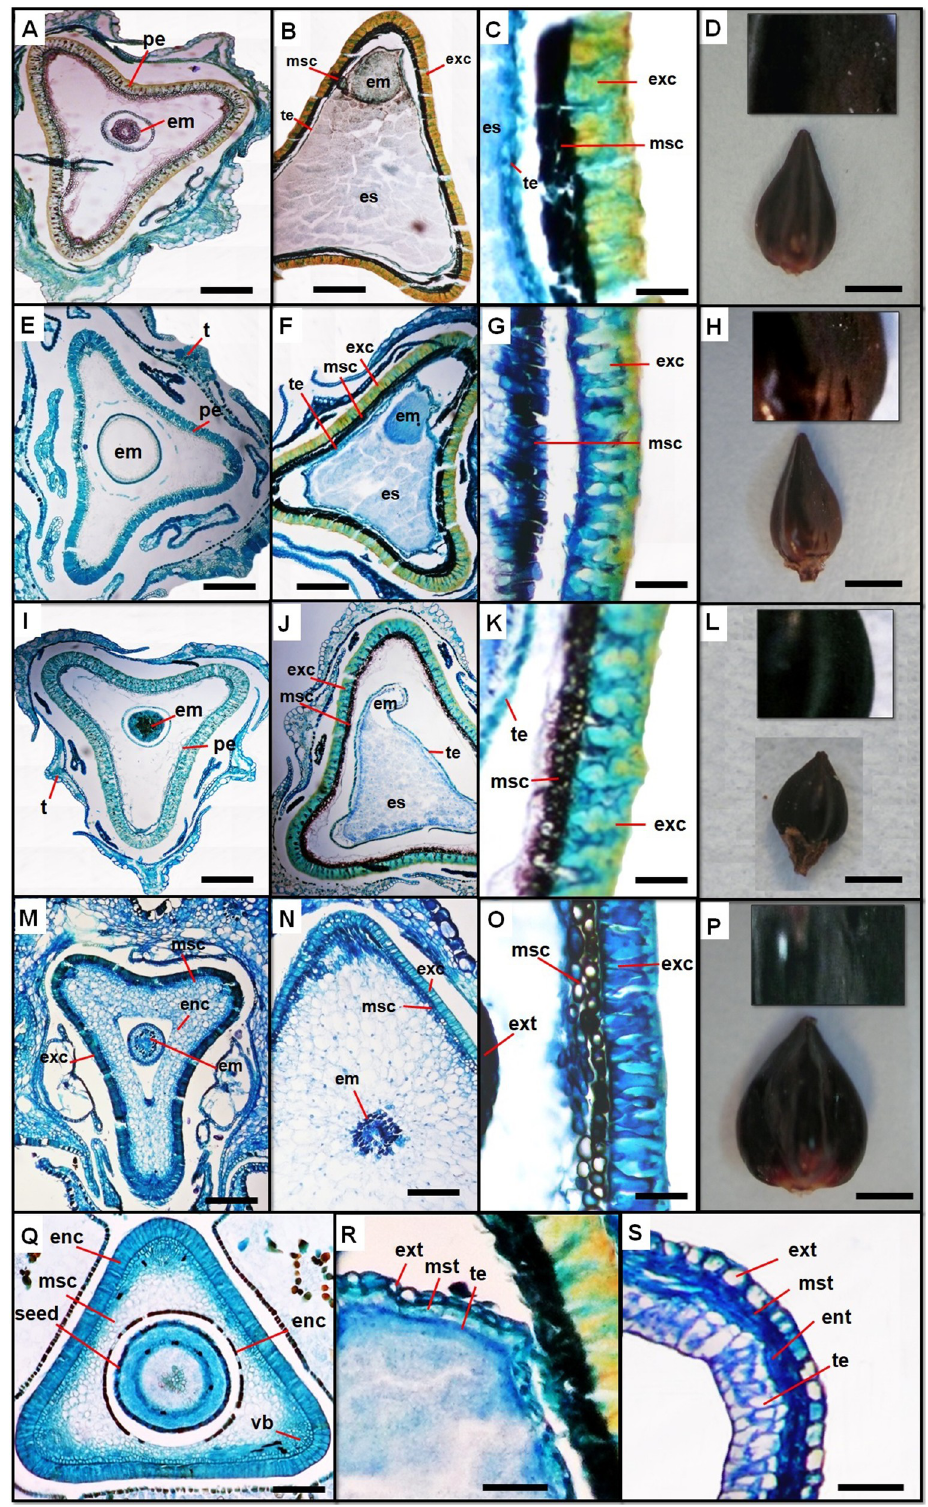
Fig 6. Morphological and anatomical aspects of fruit. P . equisetiforme var. graecum (A, B, C and D), P . equisetiforme var. peyerinhoffi (E, F, G and H), P . aviculare (I, J, K and L), and P . maritimum (M, N, O and P) under light microscope. Transversal section of premature fruit (A, E, I, M and Q). Transversal section of mature fruit (B, F, J,